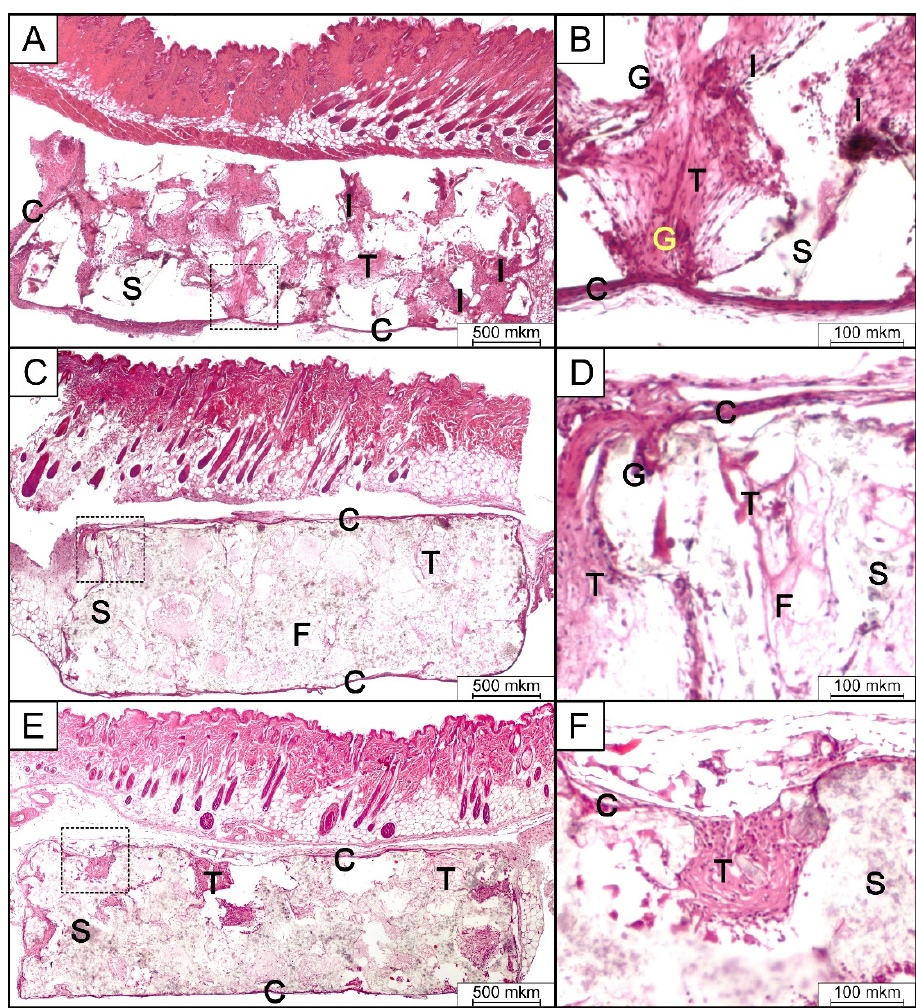
Figure 9. Light micrographs of H&E stained tissue sections of the subcutaneous implantation area in group 1 (PLA) ( A , B ), group 2 (PLA/HA 15%) ( C , D ), and group 3 (PLA/HA 20%) ( E , F ) after 2 weeks of implantation. S-scaffold; C-connective tissue capsule; T-connective tissue; F-collagen fibers; I-inflammatory infiltrates; G-giant multinucleated cell. Table 3. Semi-quantitative evaluation of the histological local response parameters 2 weeks